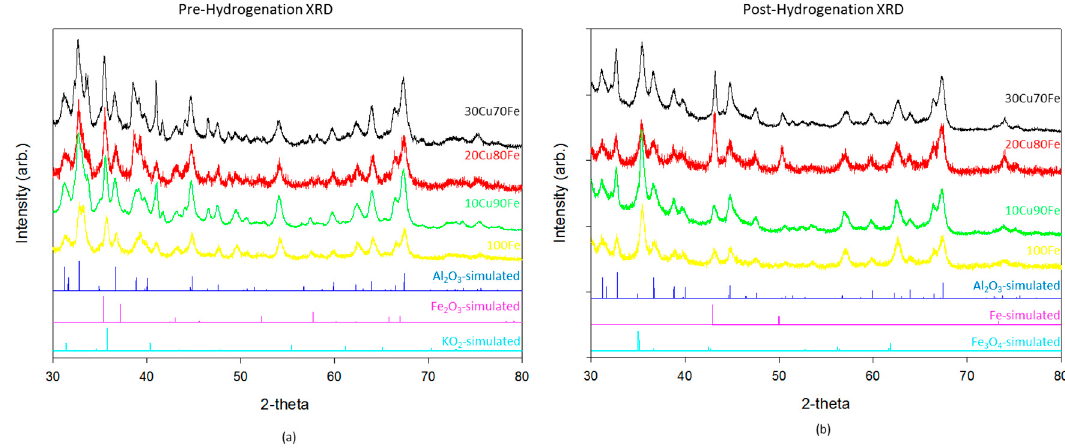
Figure 1. ( a ) Powder X-ray diffraction patterns of 100Fe/K (orange), 90Fe10Cu/K (grey), 80Fe20Cu/K (light blue), and 70Fe30Cu/K (dark blue) after calcination but before reduction and CO 2 hydrogenation. For comparison, simulated patterns for γ -Al 2 O 3 (yellow), KO 2 (blue), and Fe 2 O 3 (green) are also shown; ( b ) Powder X-ray diffraction patterns of 100Fe/K (grey), 90Fe10Cu/K (light blue), 80Fe20Cu/K (orange), and 70Fe30Cu/K (dark blue) after CO 2 hydrogenation. For comparison, simulated patterns for γ -Al 2 O 3 (yellow), Fe (blue), and Fe 3 O 4 (green) are also shown.